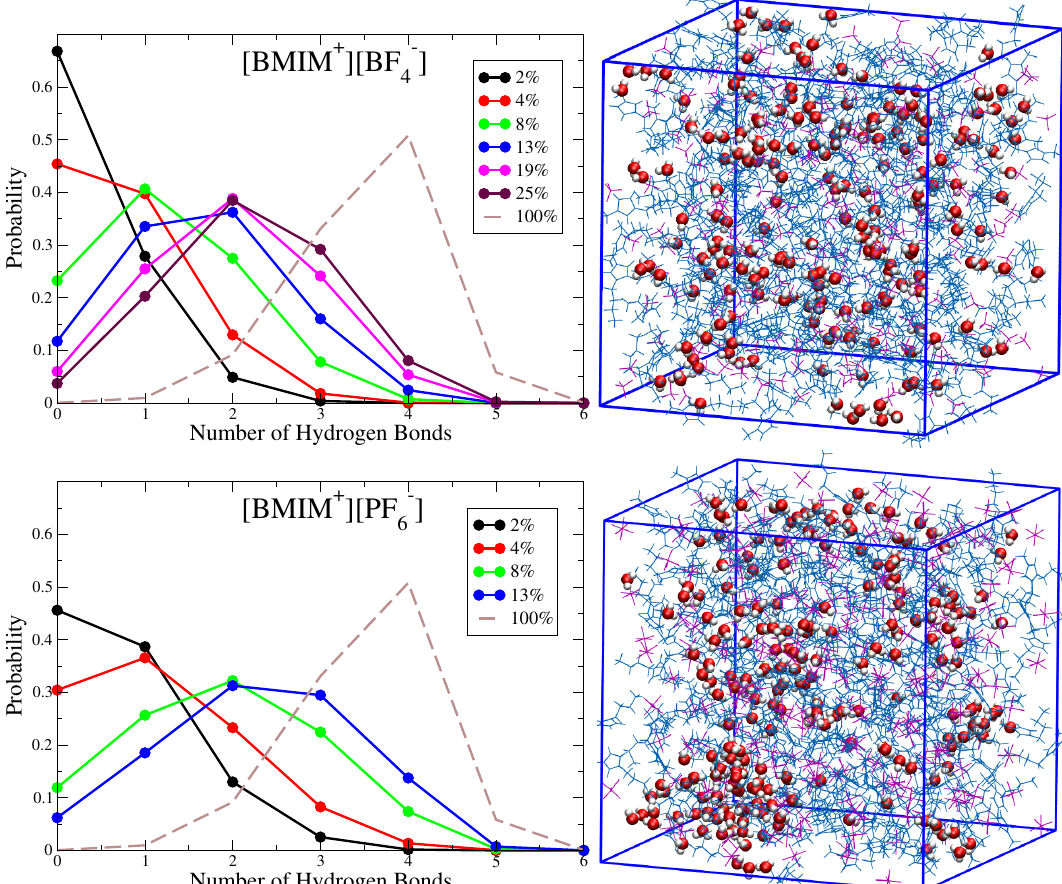
Figure 2. Histograms of number of hydrogen bonds per water molecule for [BMIM + ][BF − [BMIM + ][PF − ]water mixtures at systematically varying water volume fraction; for comparison, 6 the corresponding histogram for bulk water is shown as dashed line. Simulation snapshots are shown for corresponding systems at φ water = 0.08 water volume fraction. The statistical uncertainty is on-par with the size of the data point symbols, as estimated from standard deviation of five block averages over the trajectory. The distribution for bulk water was computed from a bulk water simulation with details analogous to those described in